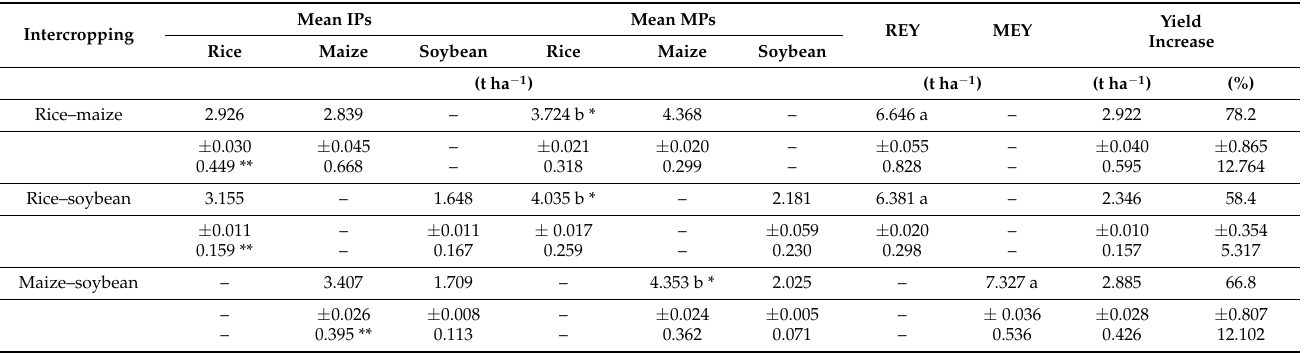
Table 3. Yield increase of rice equivalent yield (REY) and maize equivalent yield (MEY) for different intercropping practices (IPs) in comparison with monocropping practices (MPs) on rainfed areas of western Indonesia with a wet climate, 2019.